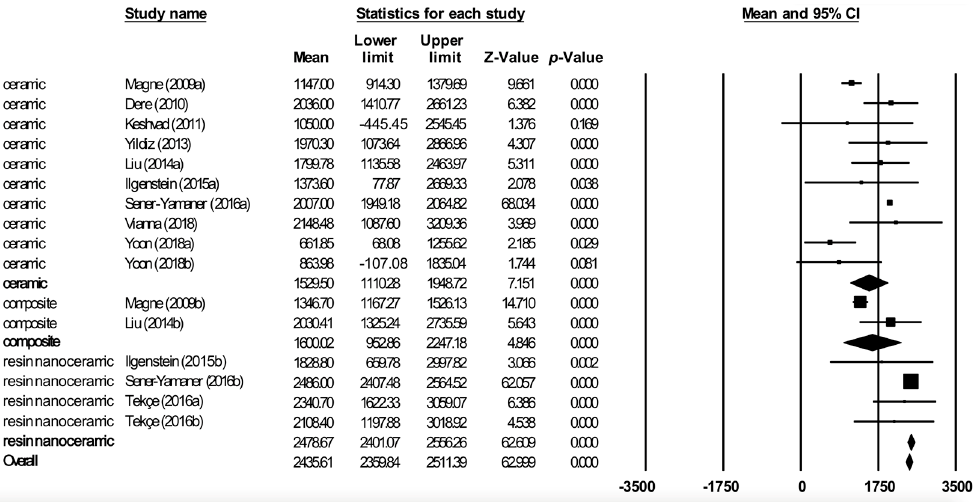
Figure 4. Forest plot of meta-analysis of materials subgroups (ceramic, composite, and resin nanoceramic). The size of the square represents the weight of each study and the diamond represents the combined results of the meta-analysis. CI is the 95% confidence interval of the mean between a lower and an upper limit.